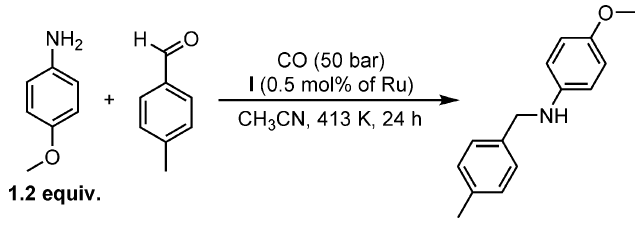
Figure 5 A model reductive amination reaction between p- tolualdehyde and p- anisidine catalyzed by complex I .